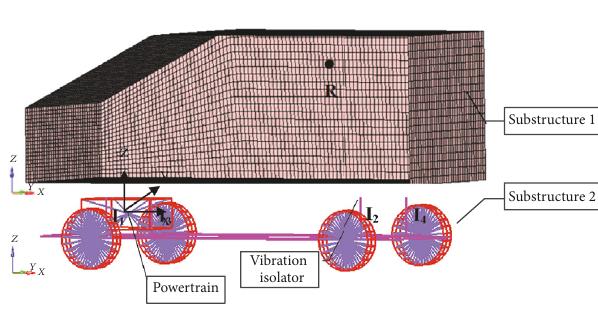
Figure 3: Simple vehicle model for substructure method.